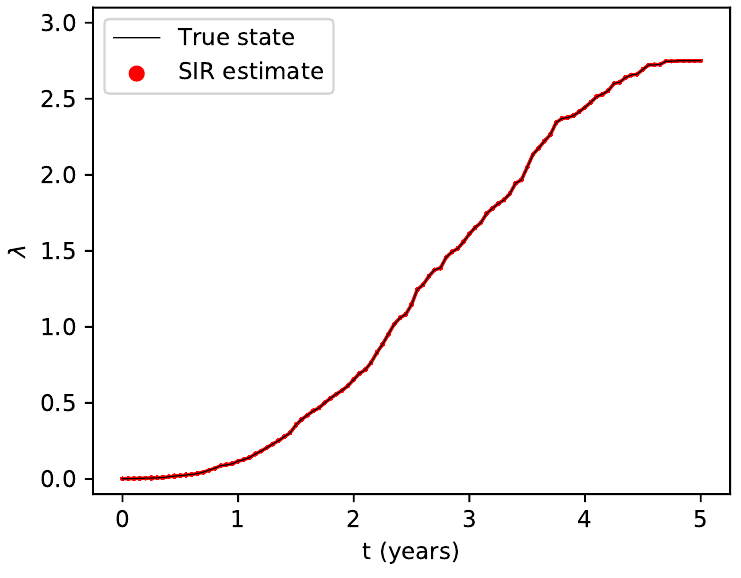
Figure 7. Degradation state online estimation with time-varying pump power—a posteriori distribution (dot size represents particle